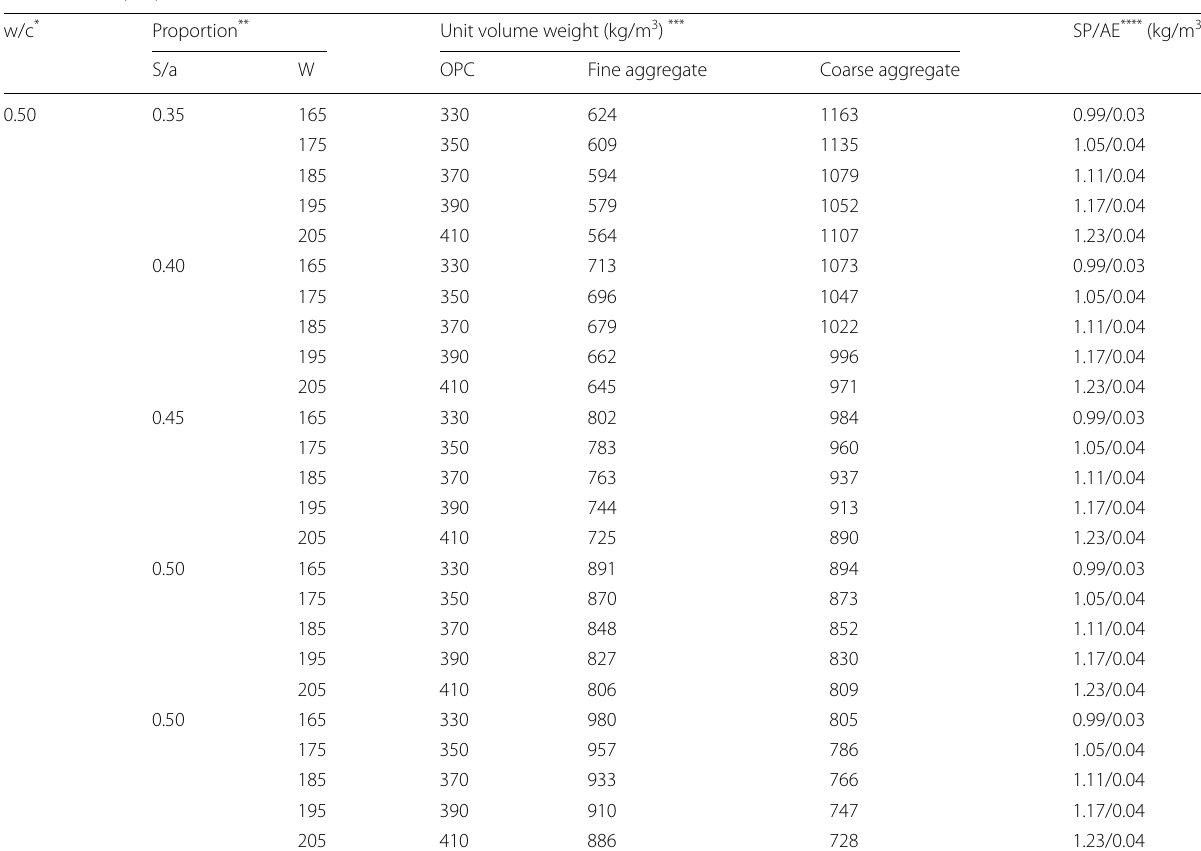
Table 2 Mix proportions of normal concrete